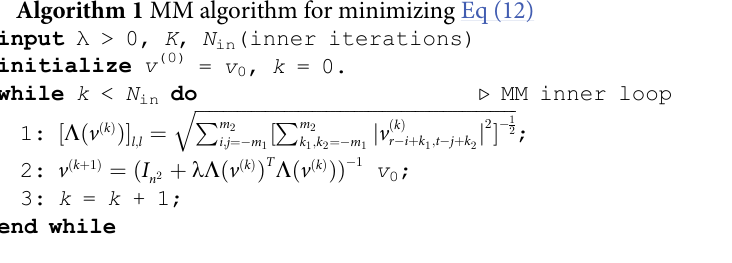
Algorithm 1 MM algorithm for minimizing Eq